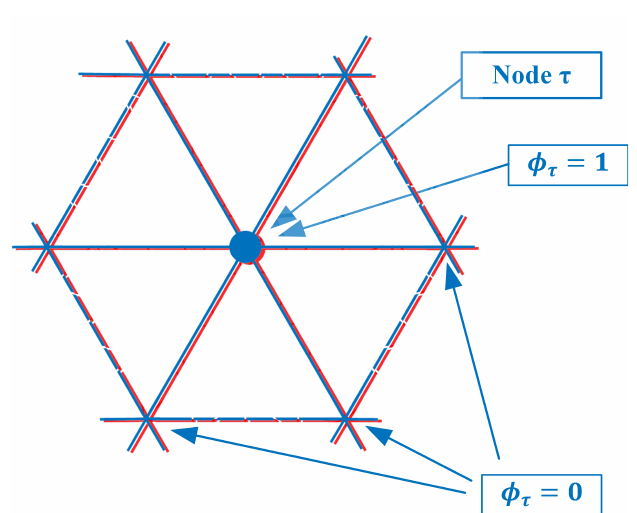
Figure 4. Forward solution mesh and parameter mesh overlap